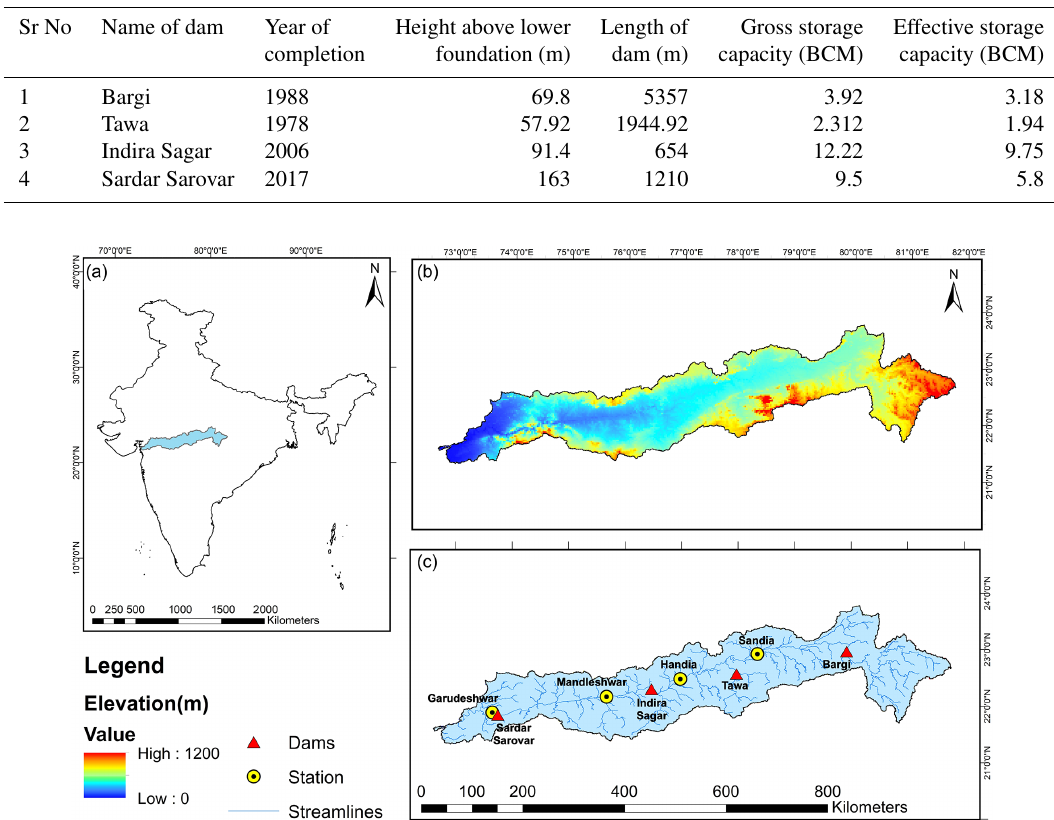
Figure 1. Basic information about (a) location in India, (b) topography, (c) streamlines, location of streamflow gauge stations and reservoirs.